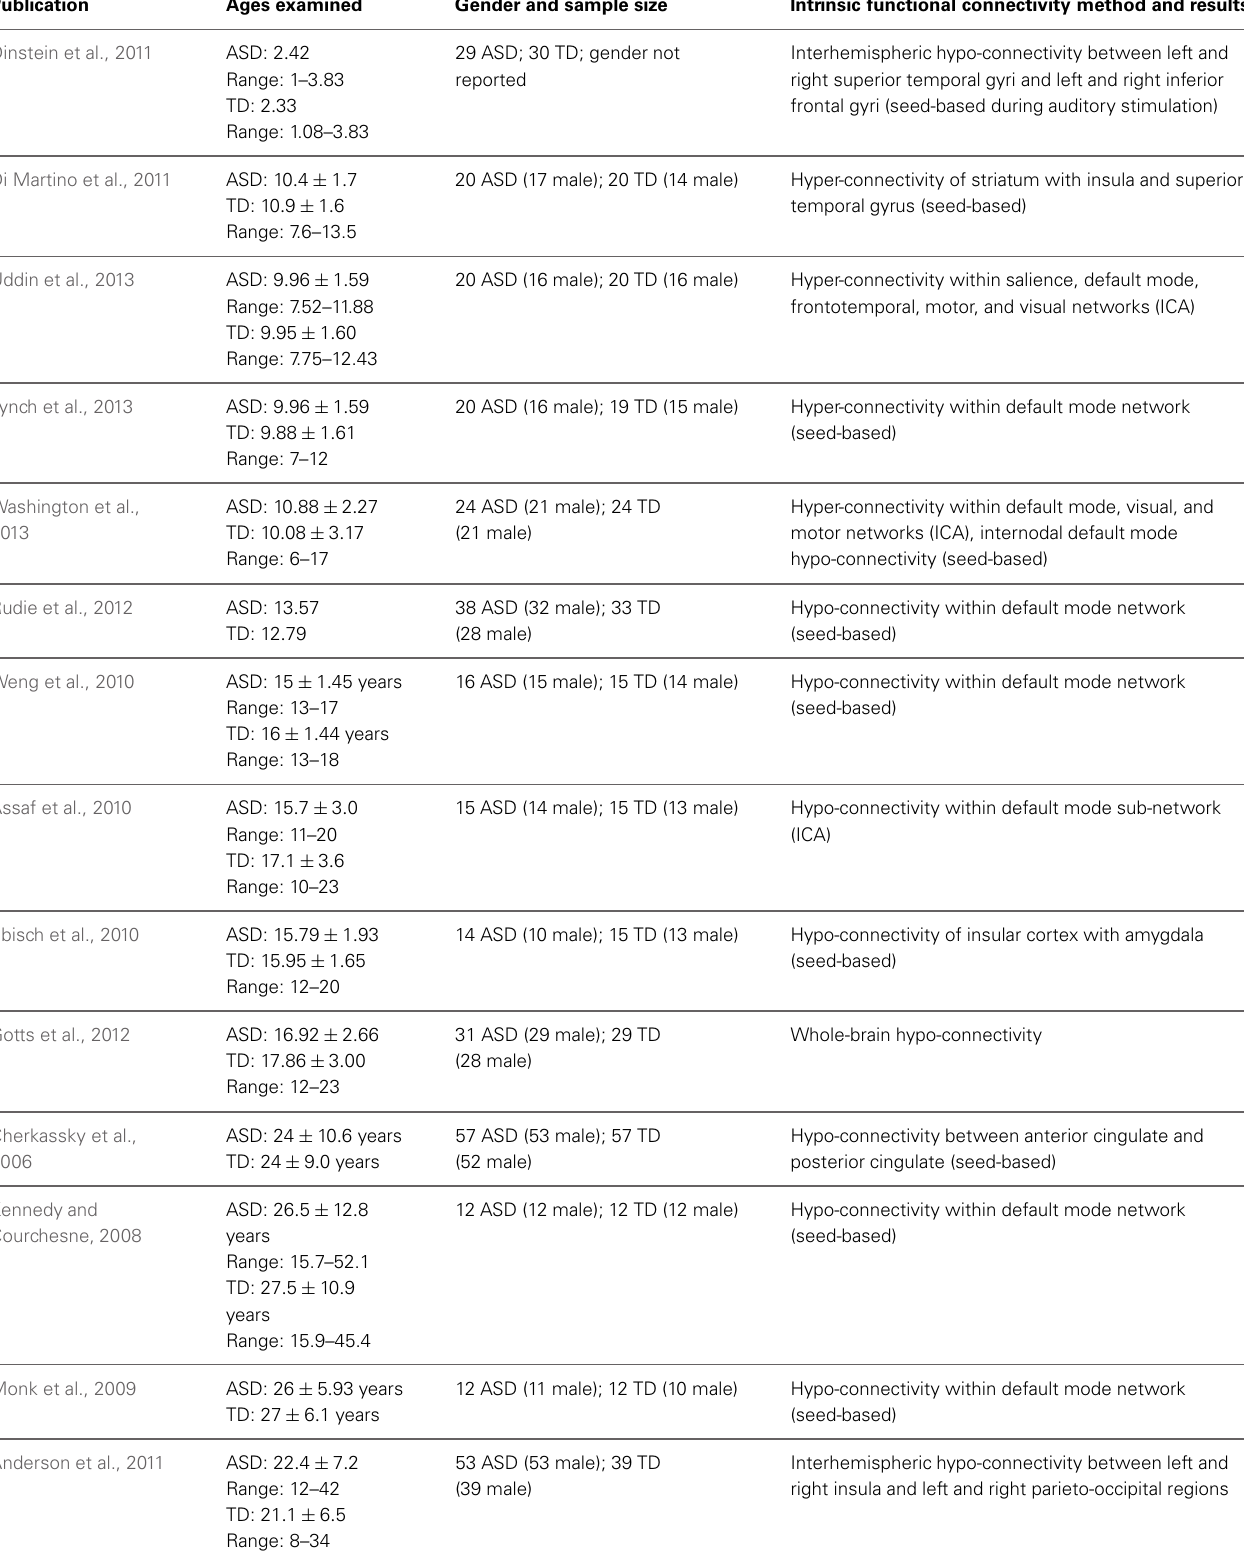
Table 1 | Resting-state functional connectivity MRI studies in